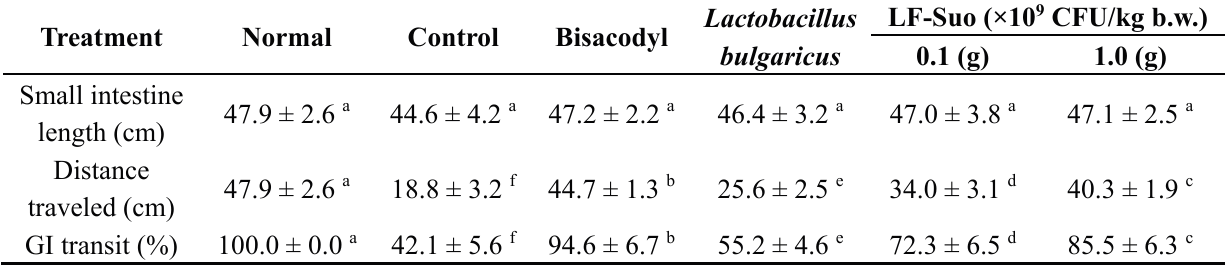
Table 5. Effects of samples on gastrointestinal (GI) transit in activated carbon-induced constipation model